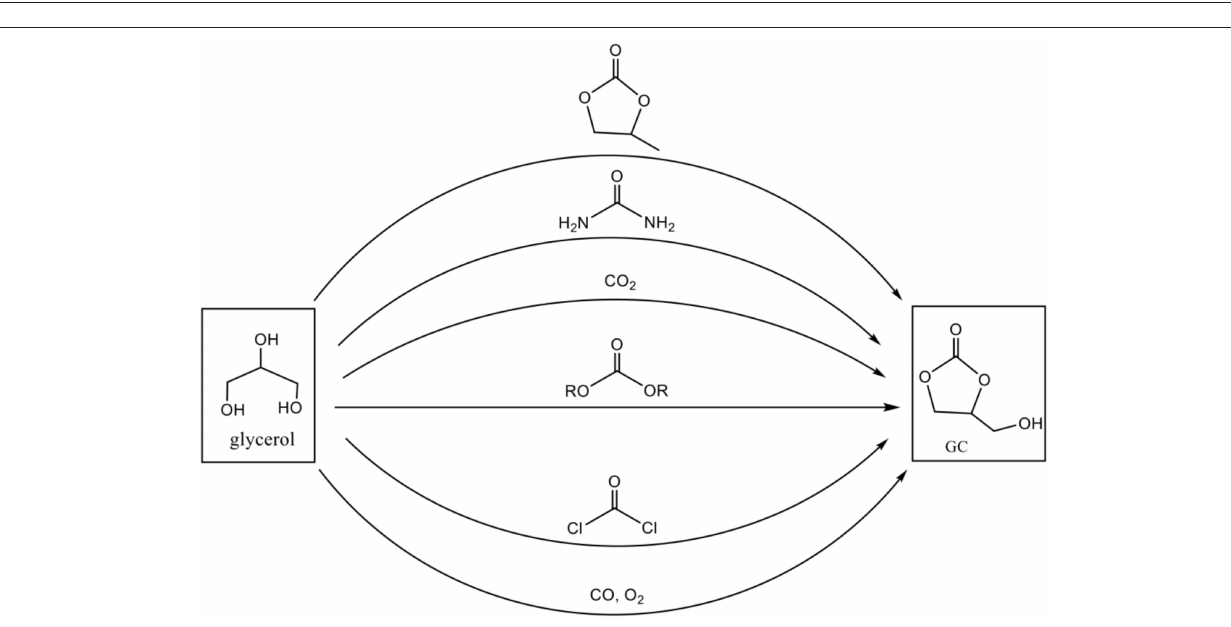
FIGURE 2 | Applications of glycerol carbonate (adapted from references Sonnati et al., 2013; Algoufi et al., 2017).